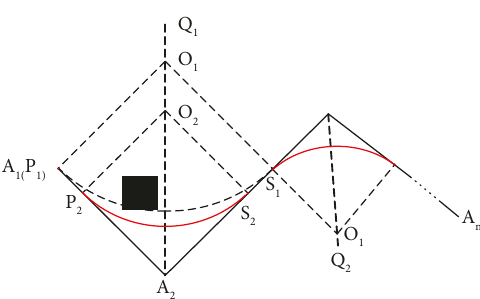
Figure 8: Adaptive arc optimization